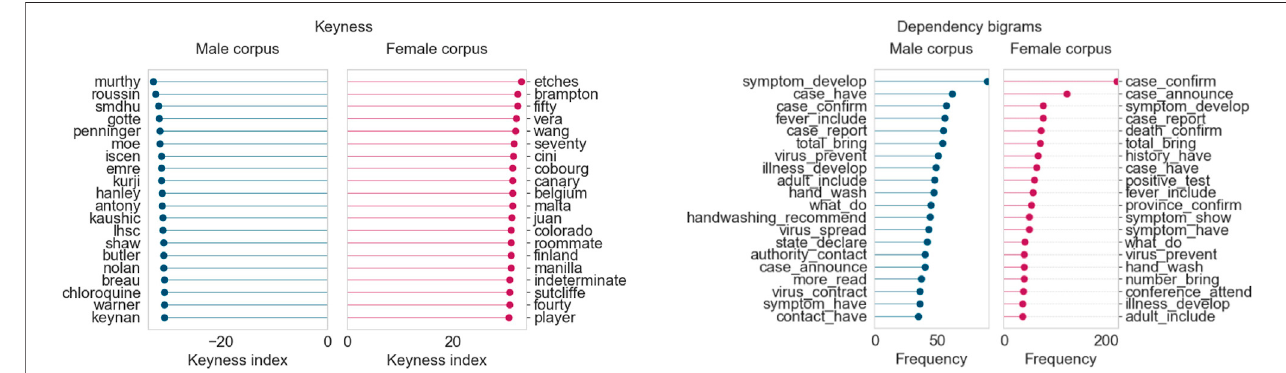
FIGURE 11 | Corpus results for top 400 articles from four “ Healthcare and COVID-19 ” topics (March 2020).